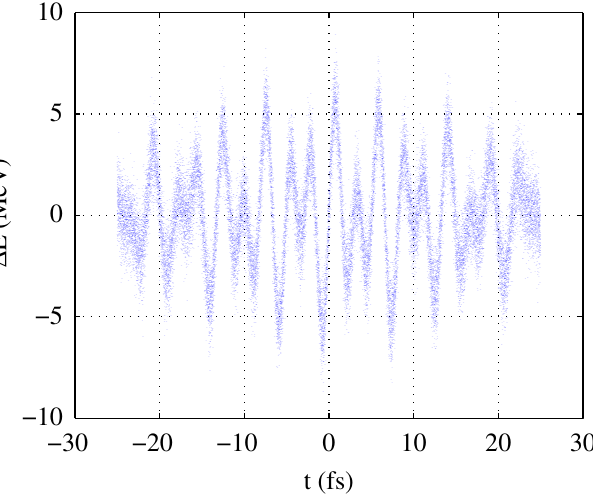
FIG. 3. (Color) Calculated longitudinal phase space of the elec- trons after interaction with two